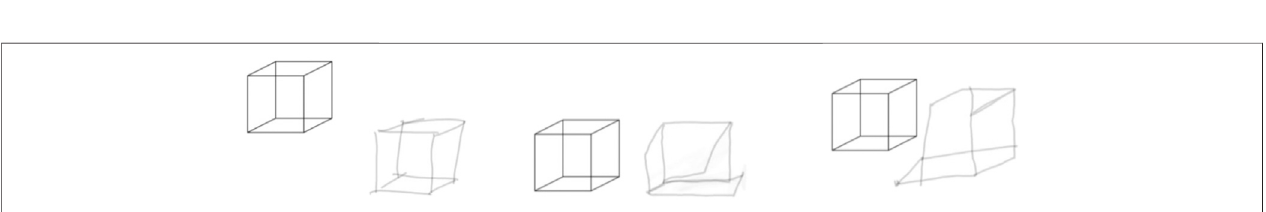
Frontiers in Computer Science |